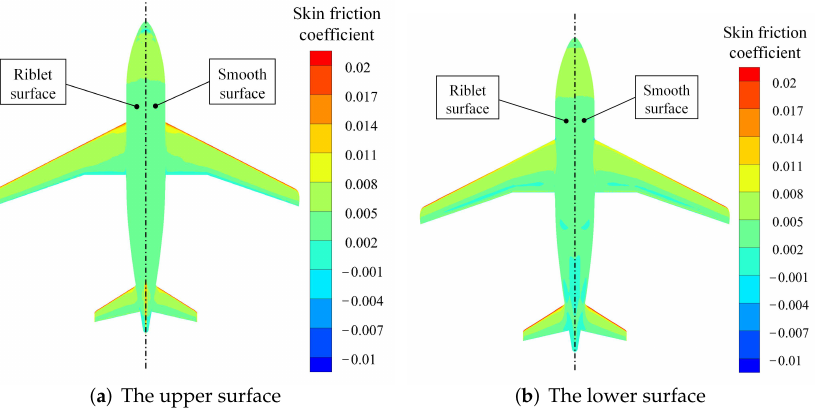
Figure 24. Distributions of the skin friction coefficient on the ribleted model and the baseline